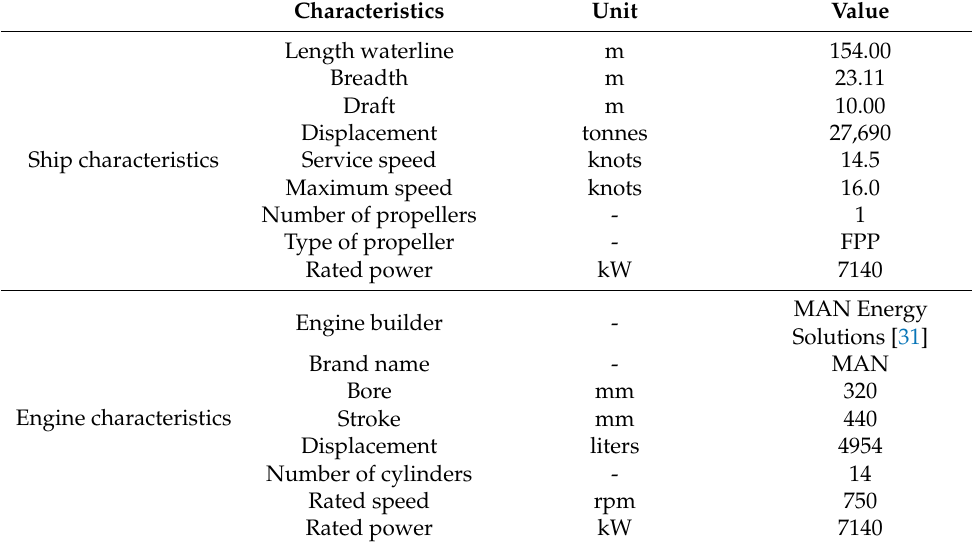
Table 1. Main characteristics of the bulk